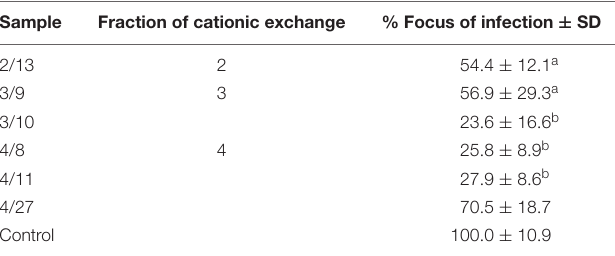
TABLE 3 | Inhibition of rotavirus SA11 infection in MA-104 cell line by selected reverse phase fractions following strategy B. Sample